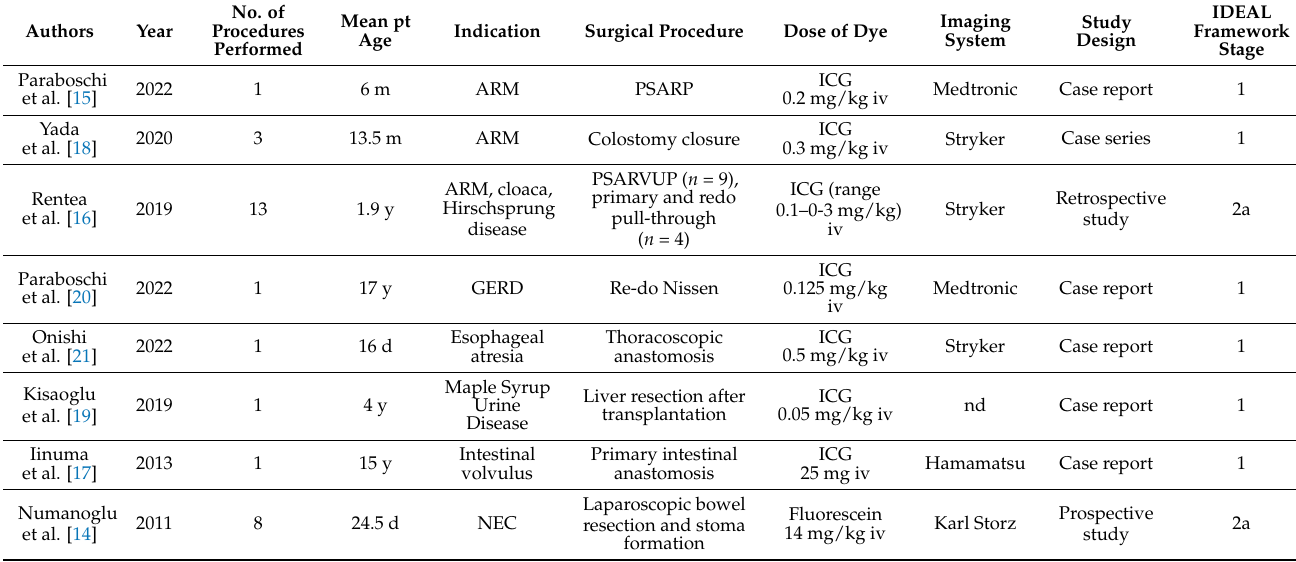
Table 2. Summary for vascular perfusion for gastrointestinal